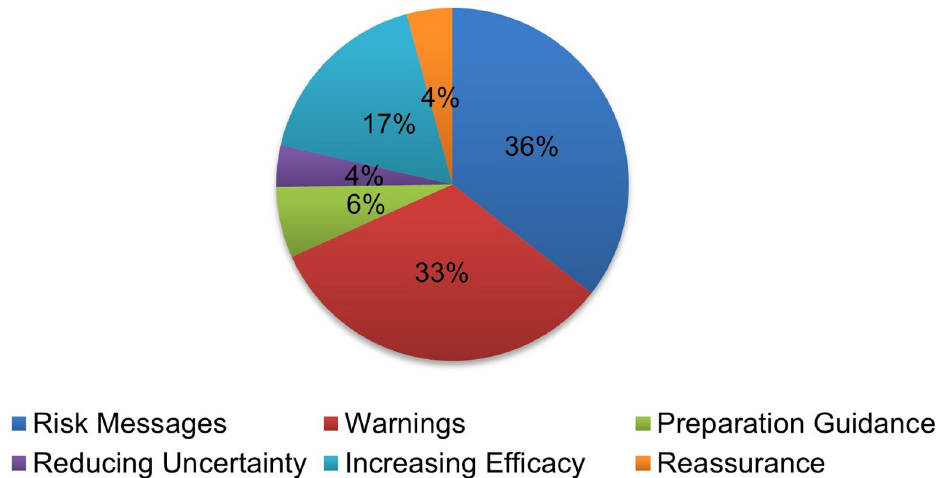
Fig 4. Percentage distribution of Crisis and Emergency Risk Communication (CERC) model themes (about Zika and dengue) found in federal health agency (i.e., CDC, FDA, NIAID, NIH) Facebook posts during 2016.